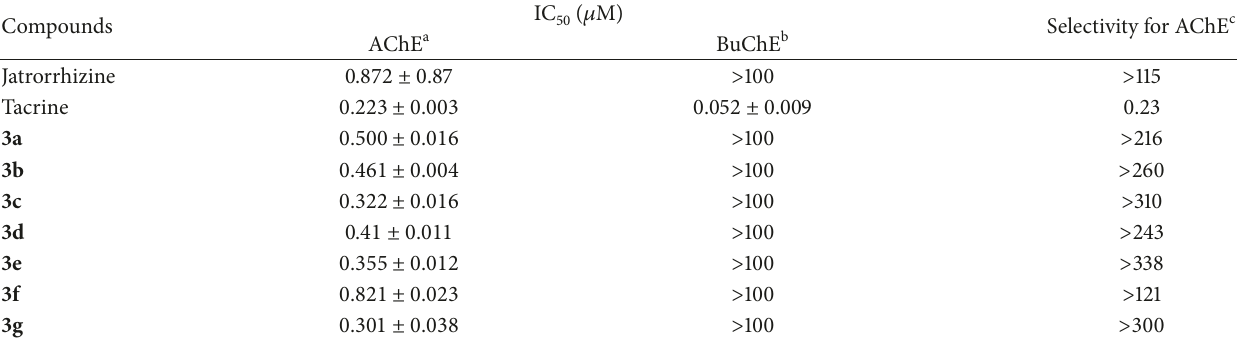
Table 1: In vitro inhibition IC 50 ( 𝜇 M) and selectivity of jatrorrhizine derivatives for AChE and BuChE. IC 50 ( 𝜇 Compounds